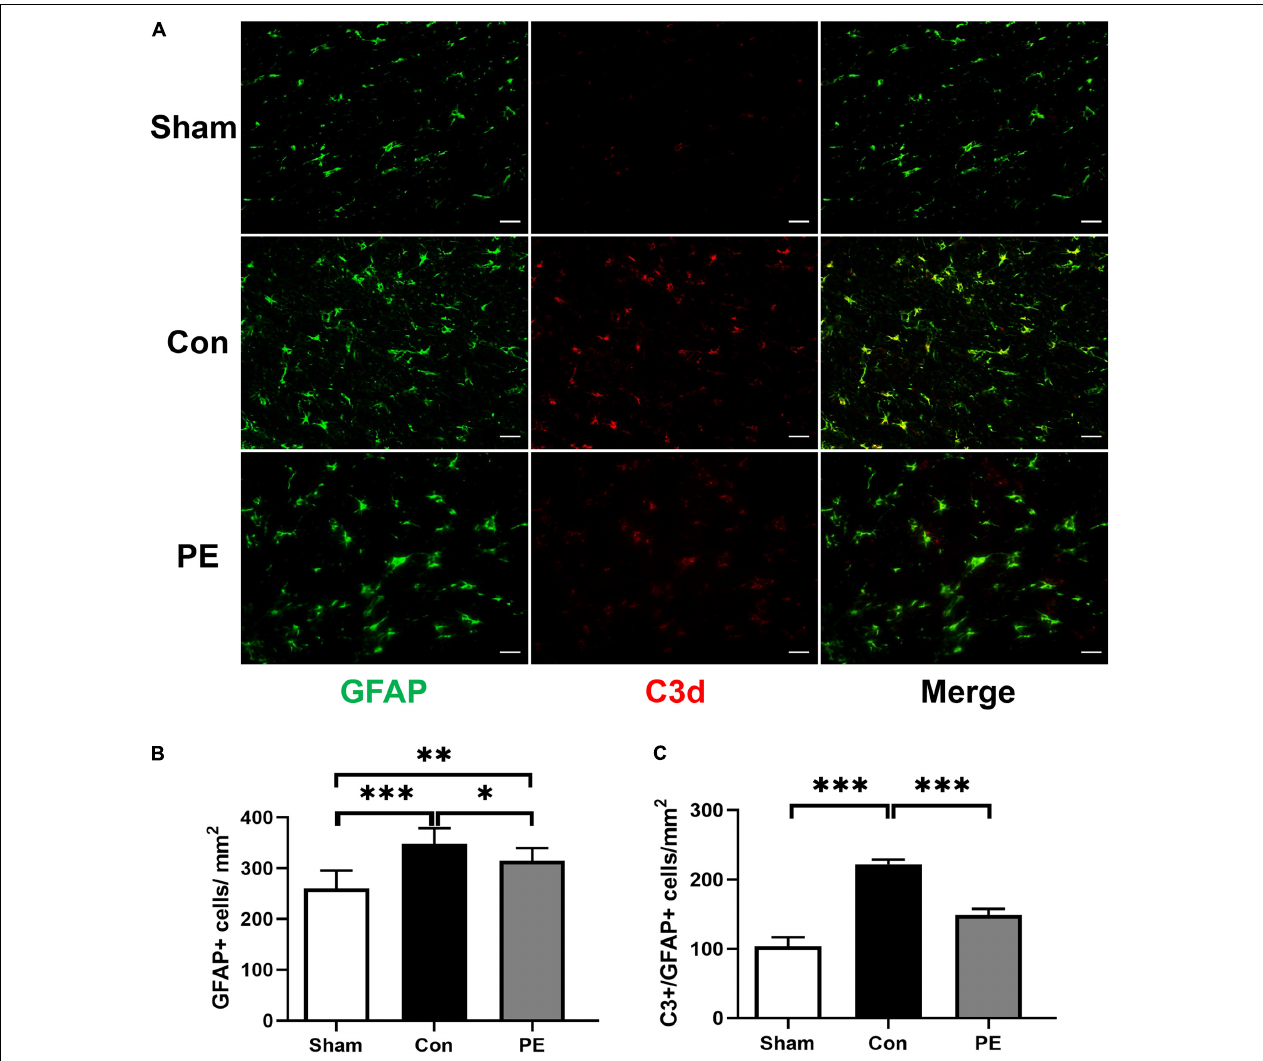
FIGURE 3 | Physical exercise decreased the number of A1 neurotoxic astrocytes. (A) Representative immunofluorescence images for GFAP (green) and C3 (red) double staining of rats in each group in the corpus callosum. Scale bar = 50 µ m. (B) The quantification of GFAP positive astrocytes and (C) C3/GFAP positive A1 astrocytes. n = 6. Experimental data are expressed as the means ± SD. ∗ P < 0.05, ∗∗ P < 0.01, ∗∗∗ P < 0.001. GFAP, glial fibrillary acidic protein; C3, complement